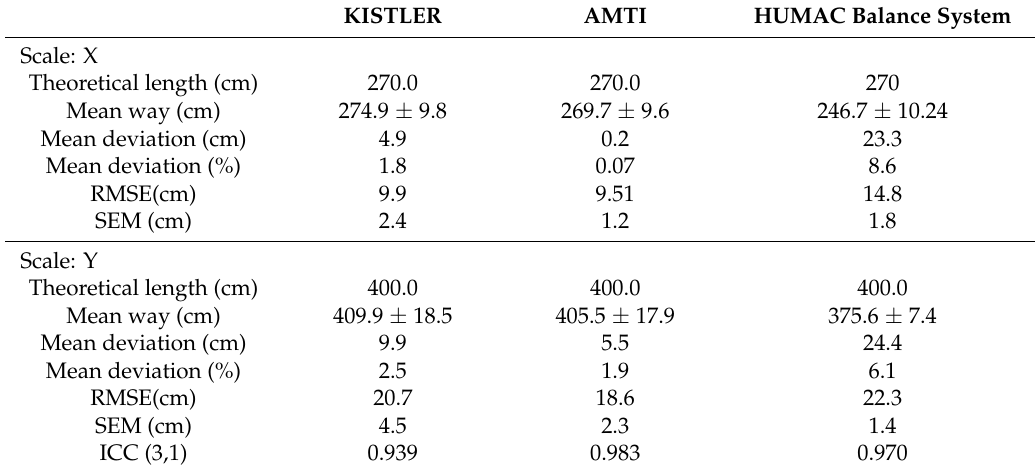
Table 2. Quantitative data of the dynamic condition in x and y